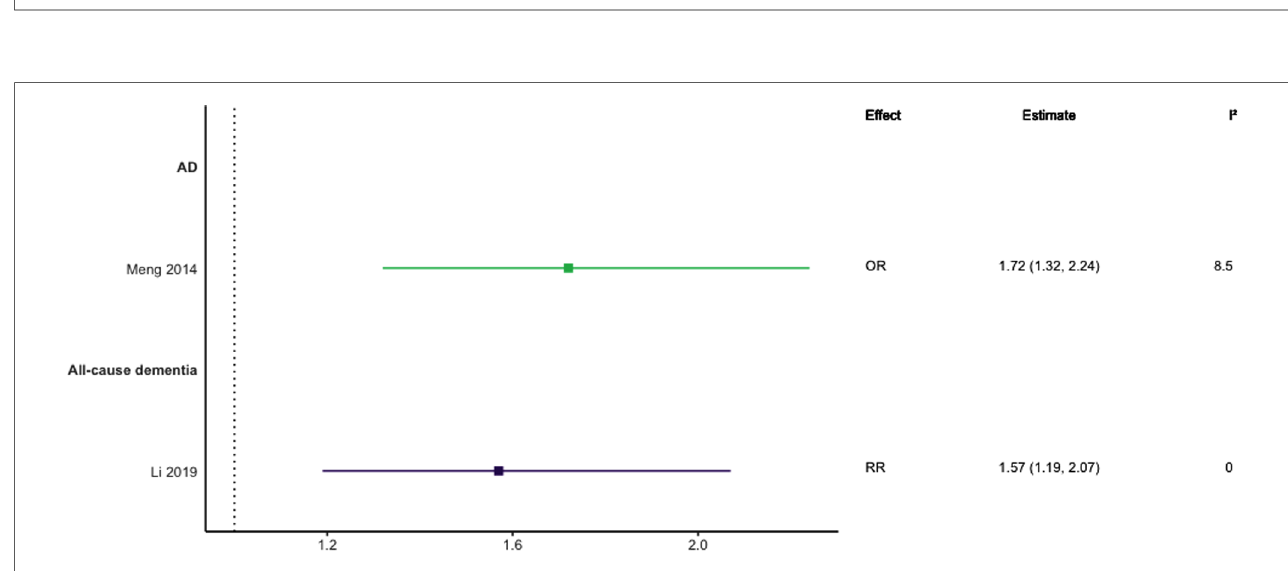
FIGURE 6 Effect estimates of meta-analyses reporting an association between TC and dementia. The vertical line represents no effect, with different colours conveying age strati fi cation. To note, Xu et al. treated ORs as approximates to RRs, as such, violations of this assumption may have implications for the comparability of ORs and RRs, meaning that interpretation of these pooled estimates should be done cautiously. Moreover, SMDs have been converted to approximate ORs (cid:1) p (cid:2) SMD using OR ¼ exp 3